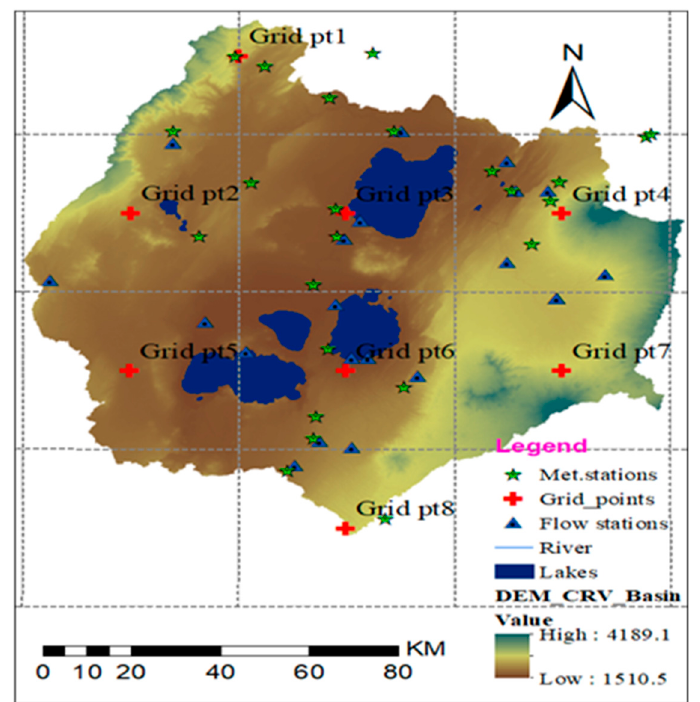
Figure 3. Coordinated regional climate downscaling experiment (CORDEX) grid points and selected meteorological stations in the study area.